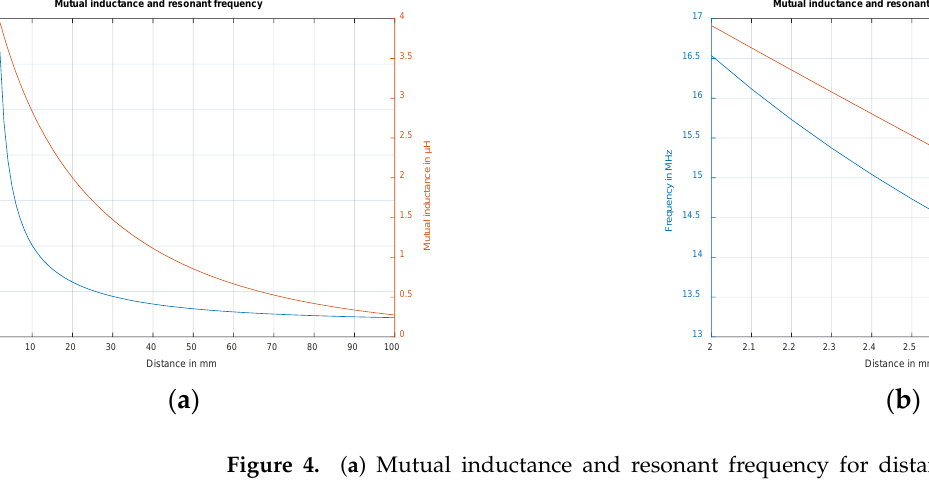
Figure 4. ( a ) Mutual inductance and resonant frequency for distances h between 2–100 mm; ( b ) Mutual inductance and resonant frequency for distances h between 2–3